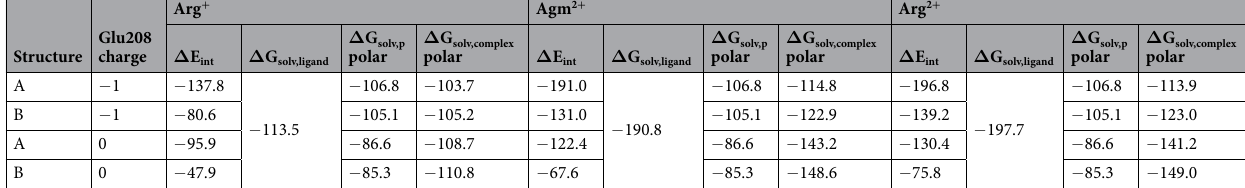
Table 2. Contributions to the free energies of binding calculated using a QM procedure. Gas-phase interaction energies ( Δ E int ) and polar contributions to the solvation free energies ( Δ G solv,complex , Δ G solv,p , Δ G solv,ligand ) for Arg + , Arg 2 + and Agm 2 + .